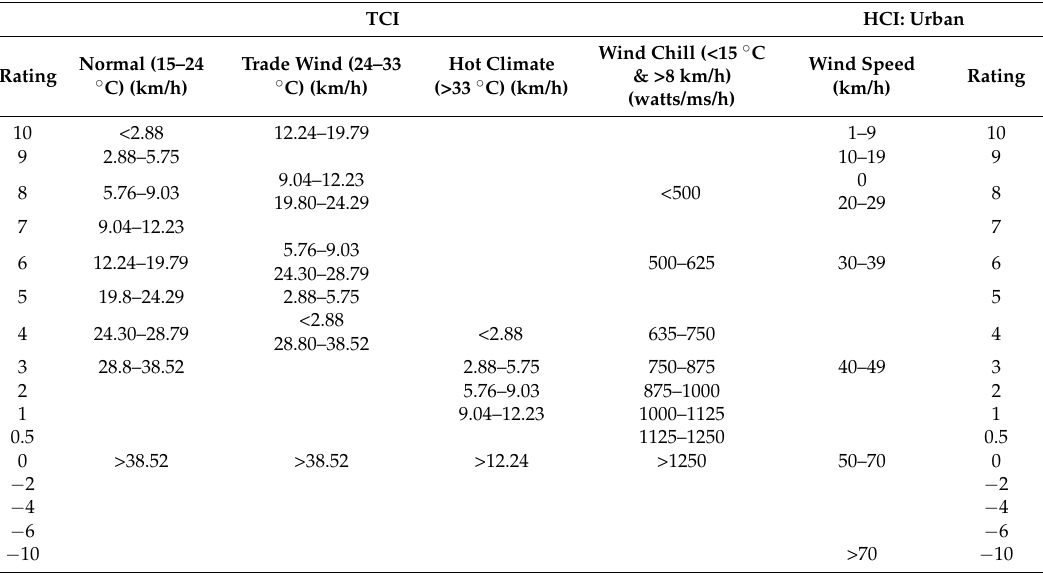
Table 6. Comparison of the wind rating